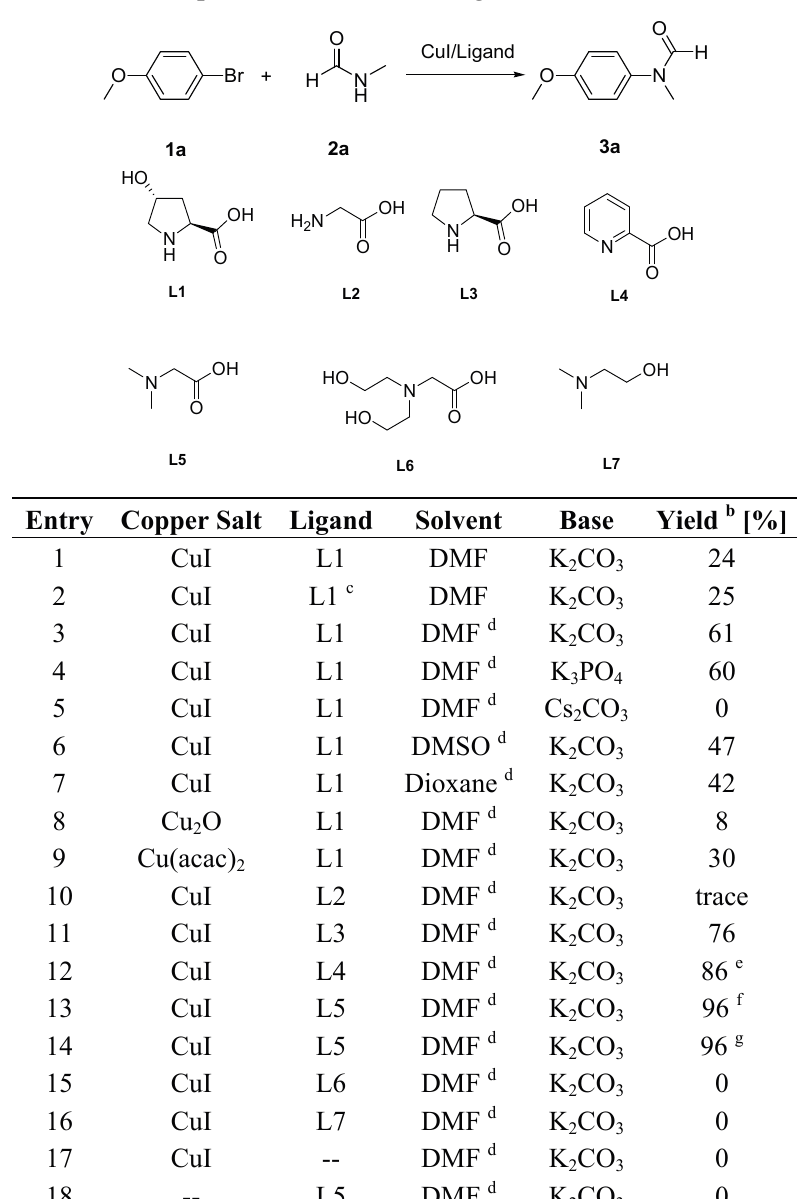
Table 1. Optimization of Goldberg reaction conditions a